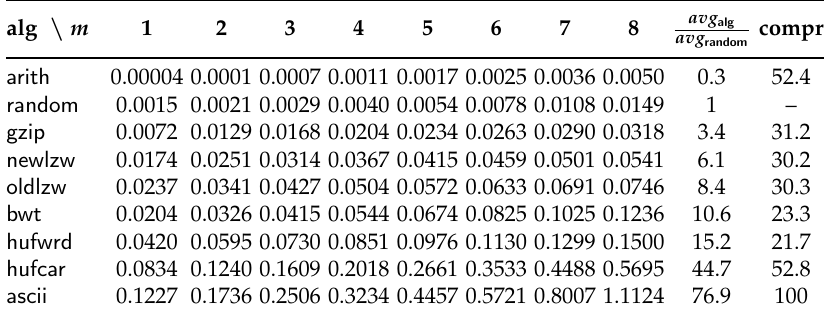
Table 1. Ratio σ of standard deviation to average within the set of 2 m values for m = 1, . . . µ